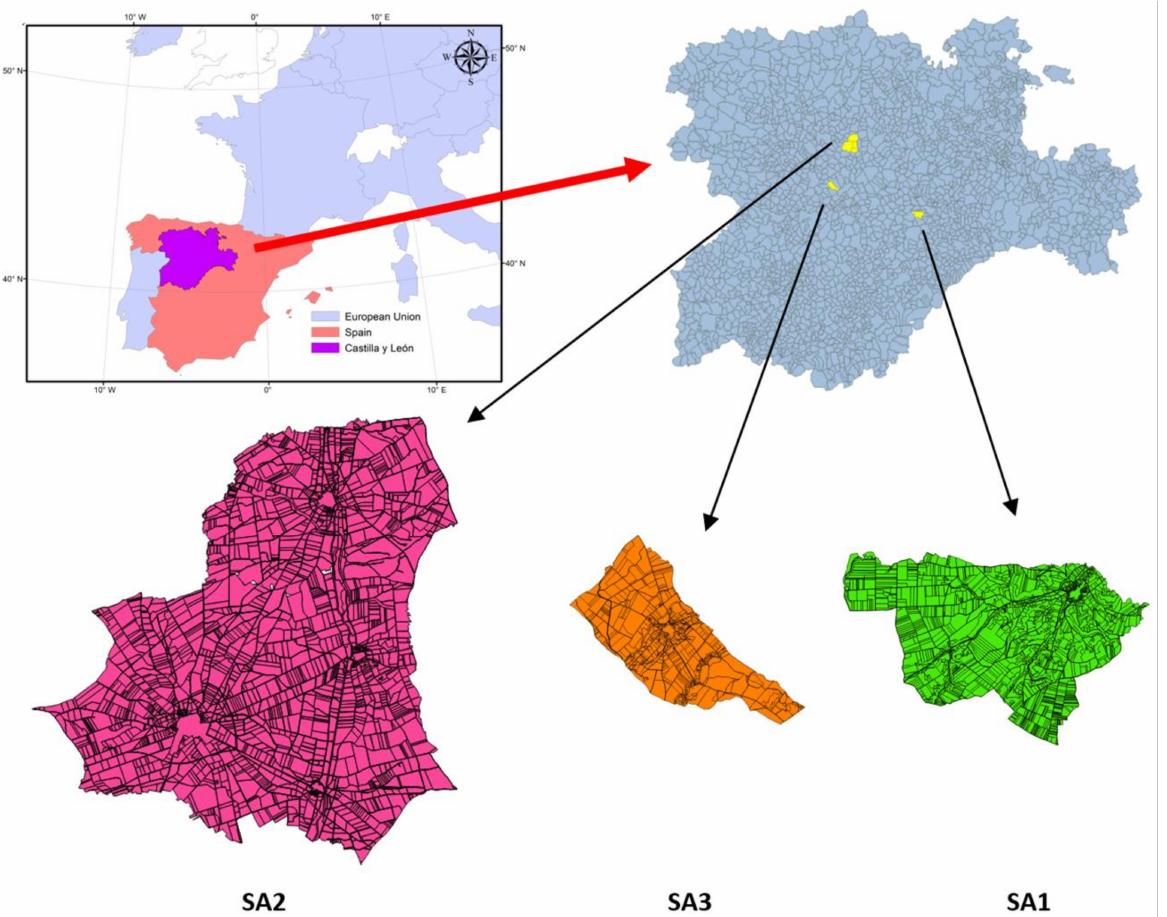
Figure 1. Location of the three study